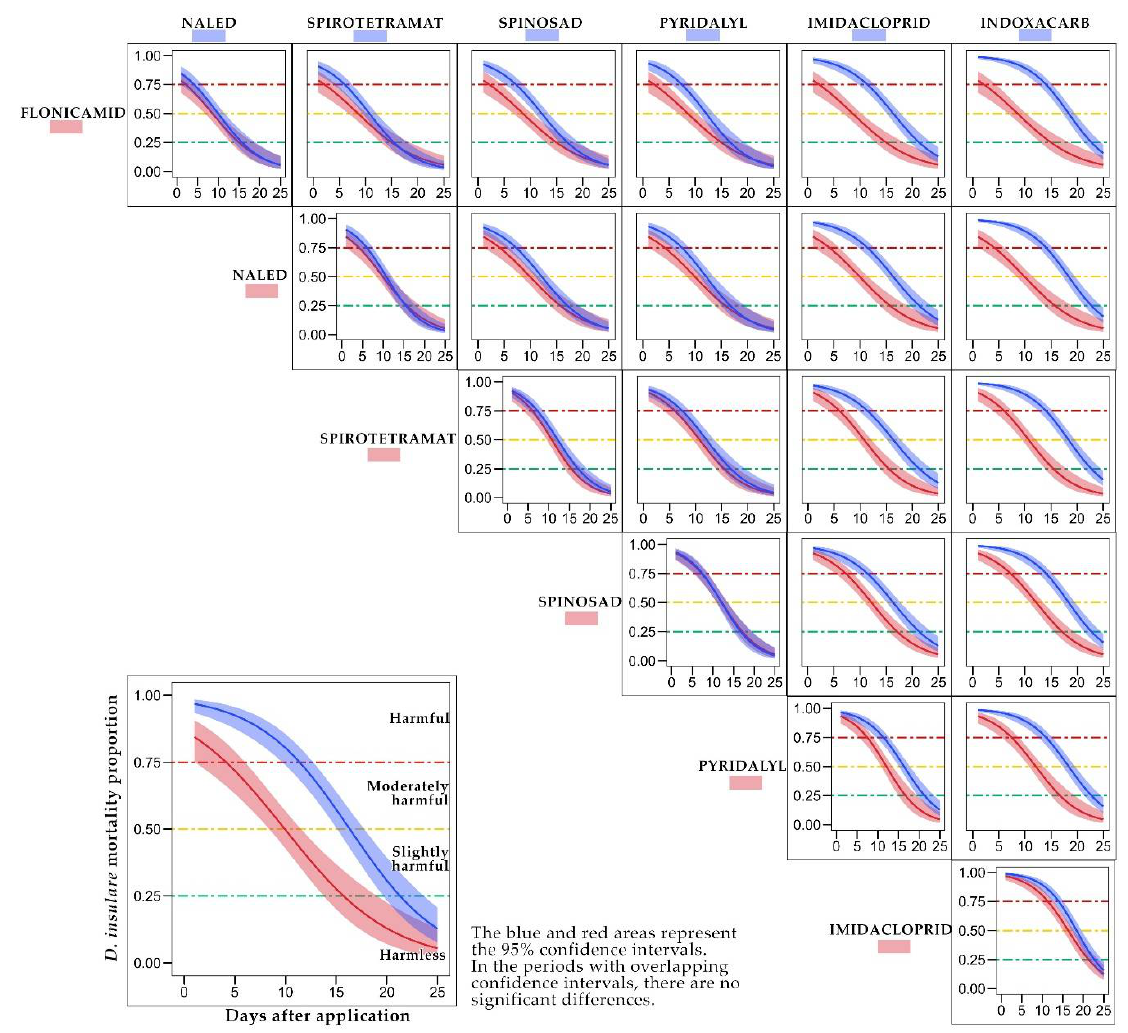
Figure 3. Comparison of the adjusted models using the 95% confidence